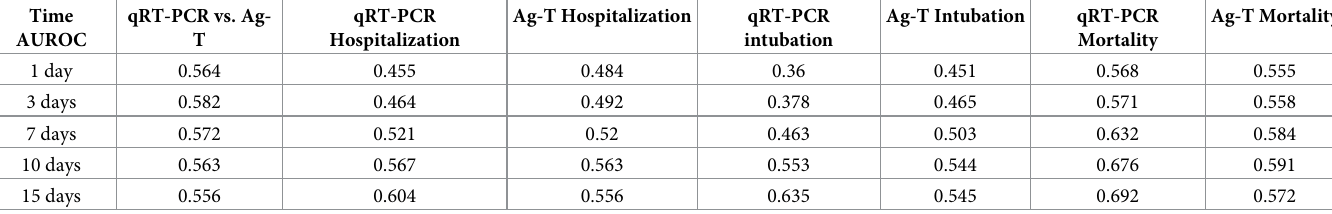
Table 3. Time-dependent area under ROC curves using inverse weighted probability with Cox regression for detection of SARS-CoV-2 infection, adjusted for age assessing the performance of rapid antigen tests compared to qRT-PCR at days 1, 3, 7, 10 and 15. The table also shows the ability of qRT-PCR or rapid antigen tests to predict hospitalization, intubation and mortality related to COVID-19 at these different time points.